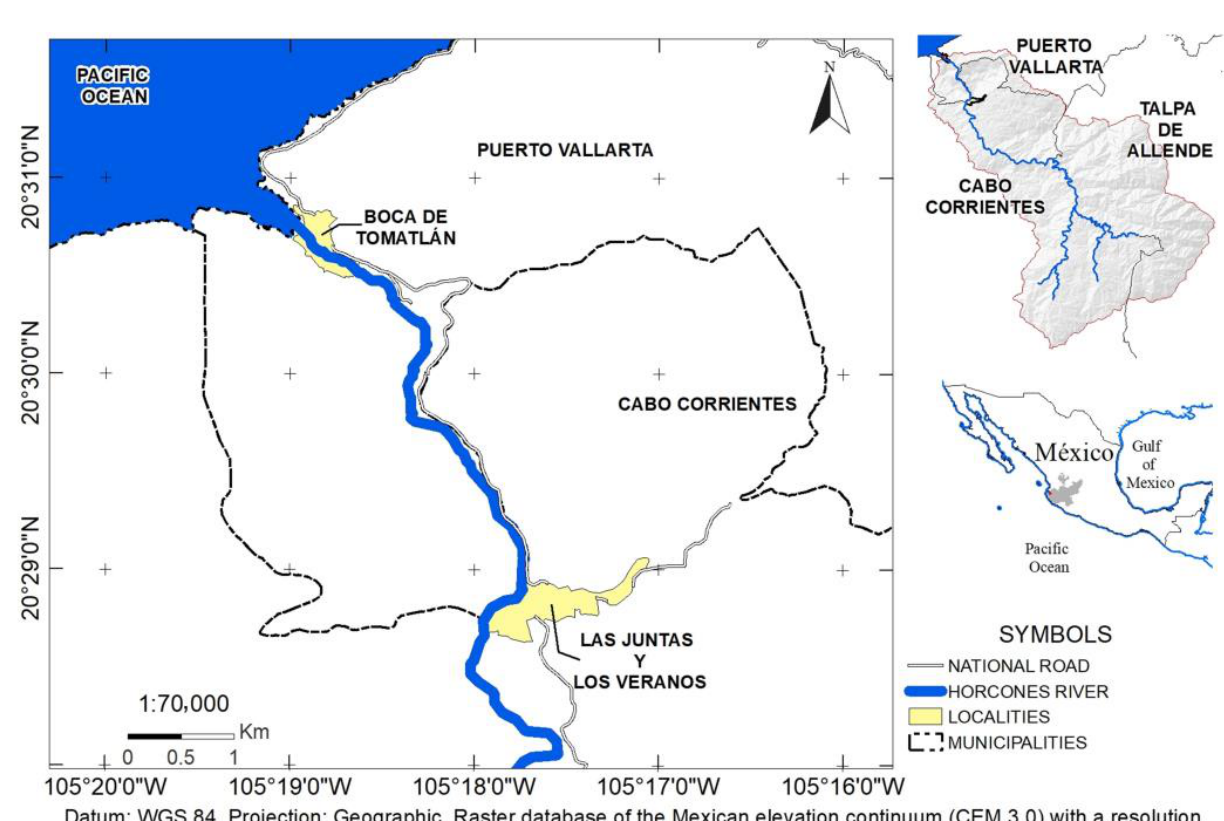
Figure 1. Location map of the Los Horcones River basin. The Los Horcones River watershed is located in western Mexico, flowing into the Pacific Ocean and spanning three municipalities, as indicated in the inset. The main human settlements within the watershed are Las Juntas y Los Veranos and Boca de Tomatlán.